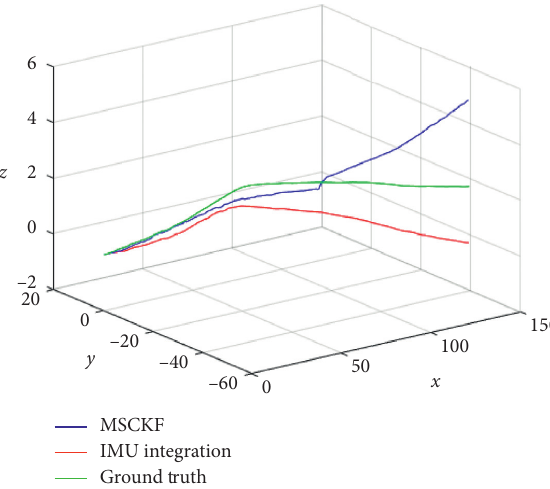
Figure 3: The trajectories of MSCKF with No. 2 datasets.